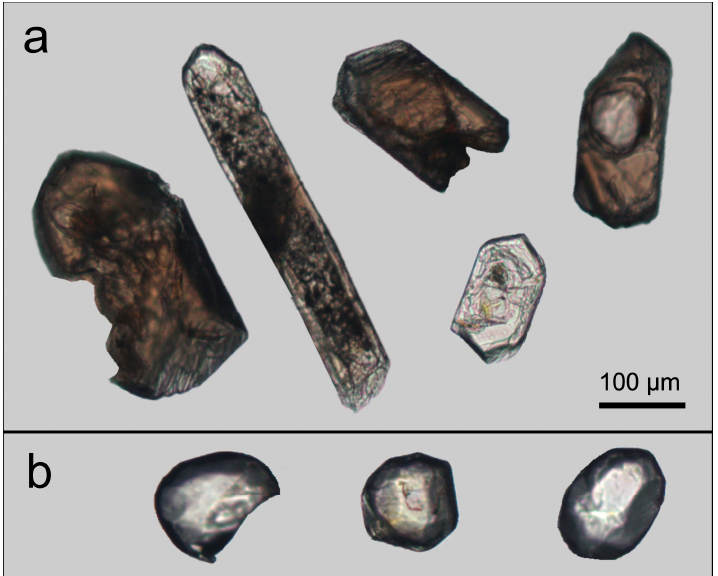
Figure 5. Transmitted-light images of zircons from the pegmatite vein (sample 101d). ( a ) dark-CL pegmatite zircons (main population); ( b ) zircons with sectorial (mosaic) in CL zoning.